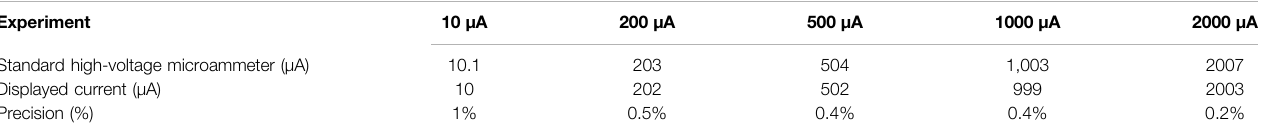
TABLE 3 | High-voltage current calibration data.